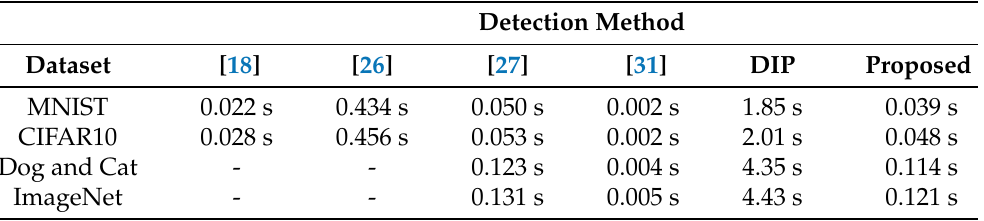
Table 2. Comparison of detection running time for one image between different detection